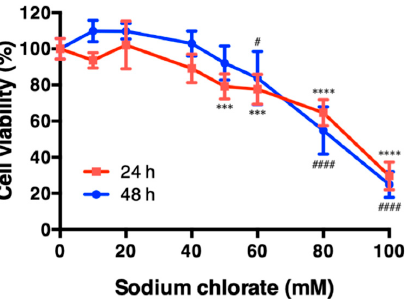
Figure 1. Effect of sodium chlorate on cell viability. HT22 cells were treated with the indicated concentrations of sodium chlorate for 24 h (red line) or 48 h (blue line) and cell viability was measured by WST-1 assay. The data are presented as the means ± SD of at least six independent cultures. *** p < 0.001, **** p < 0.0001 compared with the 24 h control; # p < 0.05, #### p < 0.0001 compared with the 48-h